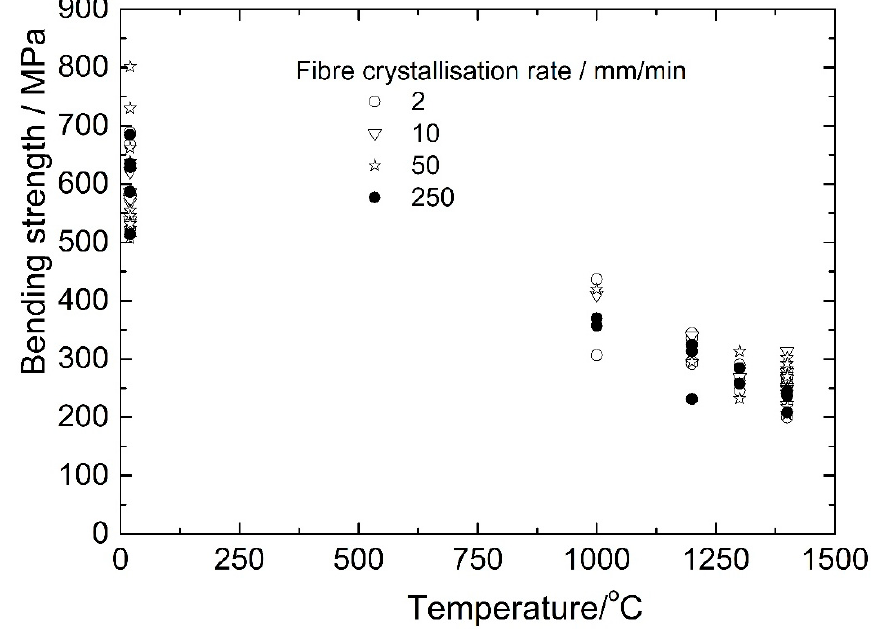
Figure 12. Strength / temperature dependence of the oxide / molybdenum composites produced according to the first scheme of fiber